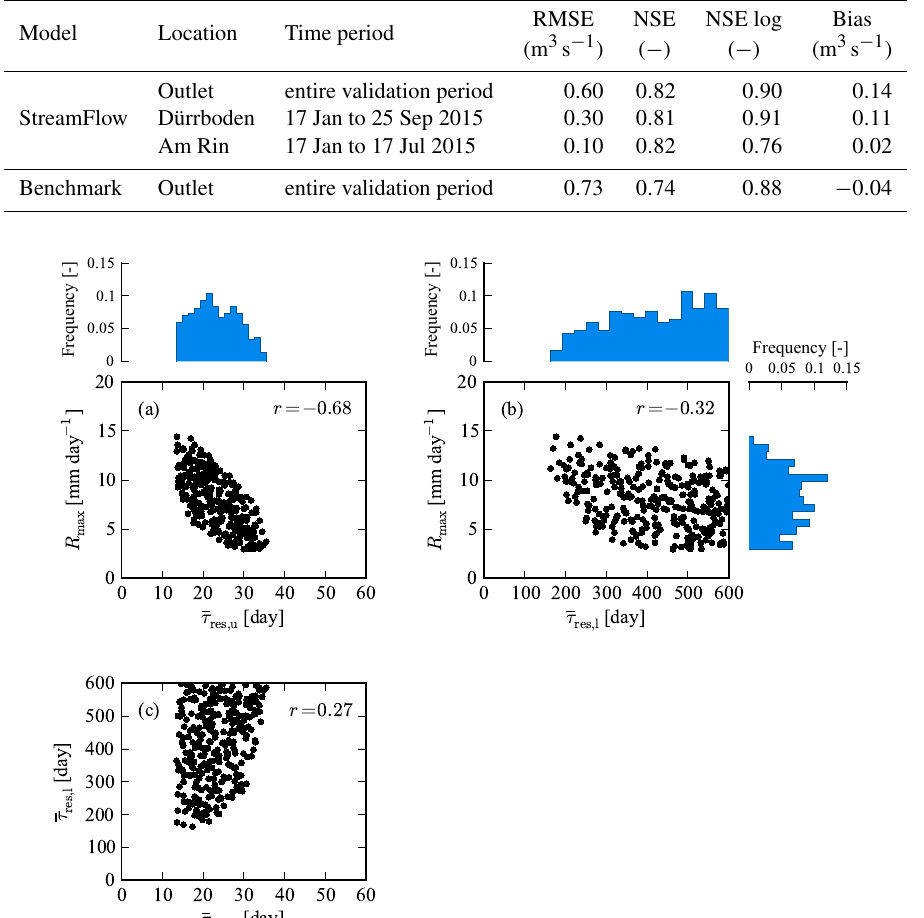
Table 4. Accuracy of the hourly discharge simulations performed by StreamFlow using the instantaneous water routing technique. The performance of the discharge benchmark model is indicated in the last row for comparison. The third column contains the period over which the error measures are computed. NSE log corresponds to the Nash–Sutcliffe efficiency computed with the logarithm of the discharge values.